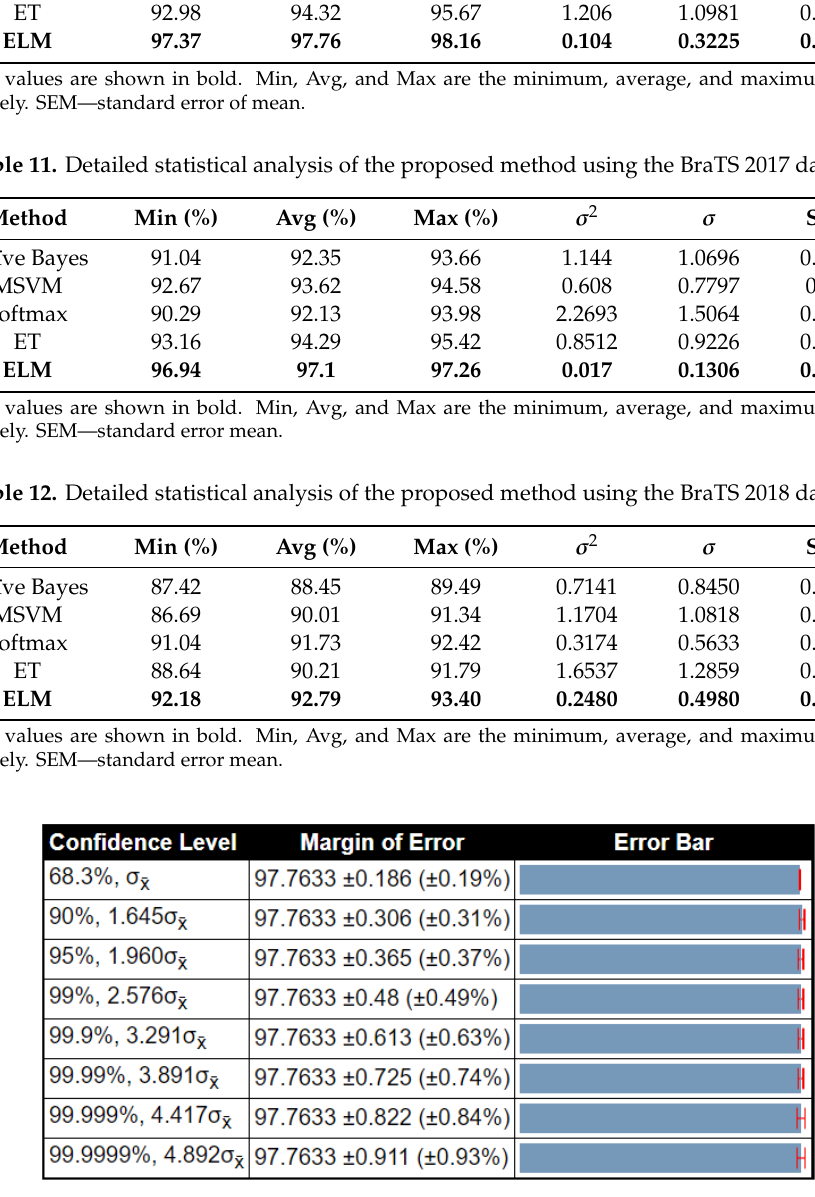
. Figure 9. Confidence interval of statistical test for different critical value of t -test (BraTS 2017 dataset). Figure 10. Confidence interval of statistical test for different critical value of t -test (BraTS 2018 dataset).